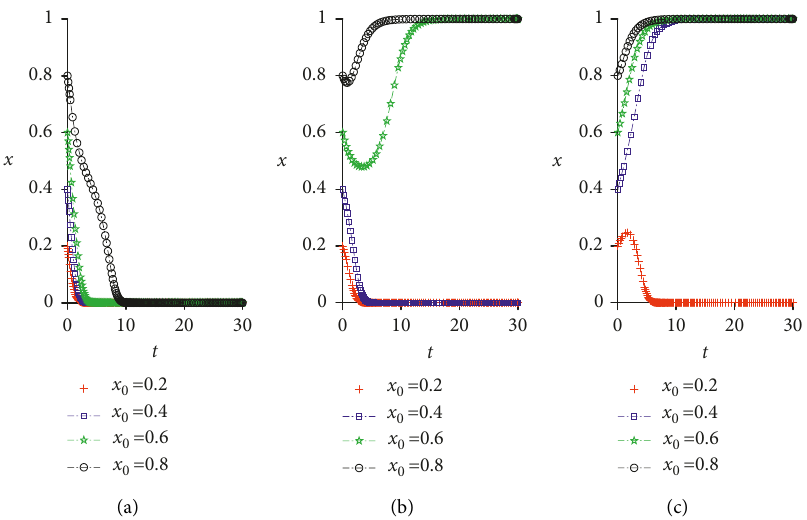
Figure 2: Impact of the initial probabilities of the two parties choosing the cooperative strategy on system evolution. Comparing (a), (b), and (c), as y 0 (initial probability of the two parties choosing the cooperation strategy) increases, the probability of the system evolving to the ideal 0 . 5; (b) y 0 0 . 7; (c) y 0 0 . state increases. (a) y 0 (cid:27) (cid:27) (cid:27)